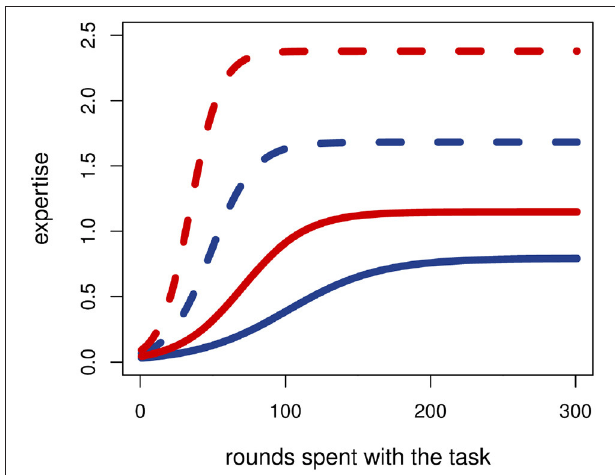
FIGURE 2 | Increasing levels of expertise for different genetic values. A higher genetic affinity grants faster learning and an altogether higher level of expertise (see also Data Sheet 1 in the Supplementary Material). Solid lines are calculated with the simulation’s initial genetic values, dashed ones with the corresponding theoretical maximums after complete specialization. In other words, dashed lines represent higher, solid lines lower genetic affinities. The colors denote two main settings: blue lines represent stronger, red ones weaker genetic trade-offs (see also Data Sheet 1 in the Supplementary Material and the main